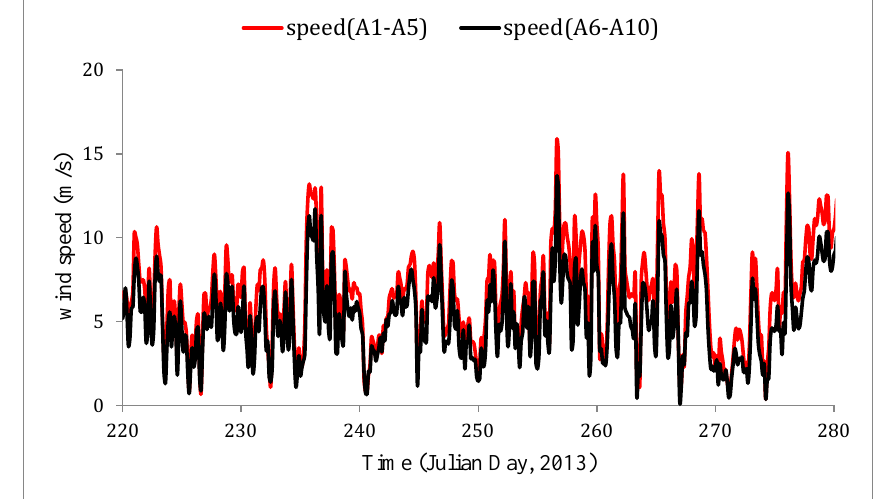
Figure 2. ECMWF wind speeds.